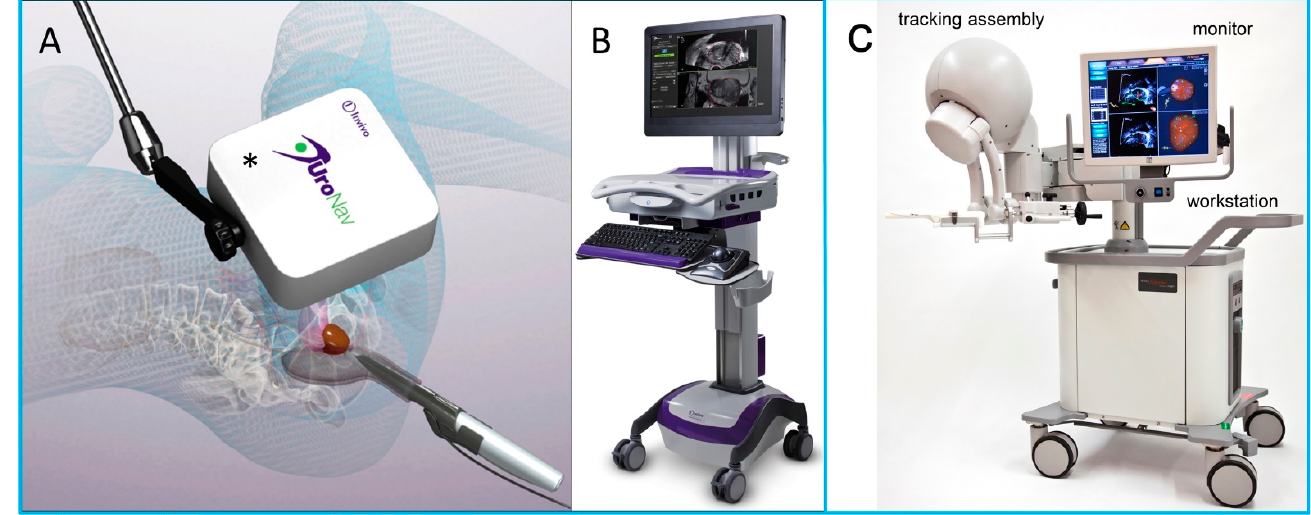
Figure 11. ( A , B ) Photo images of the UroNav US/MRI fusion system. ( A ) An electromagnetic field generator enables tracking of the transrectal US probe; ( B ) US/MRI fusion device. ( C ) Artemis US/MRI fusion system. Reprinted from [144] with permission. Table 6. A summary of US image fusion